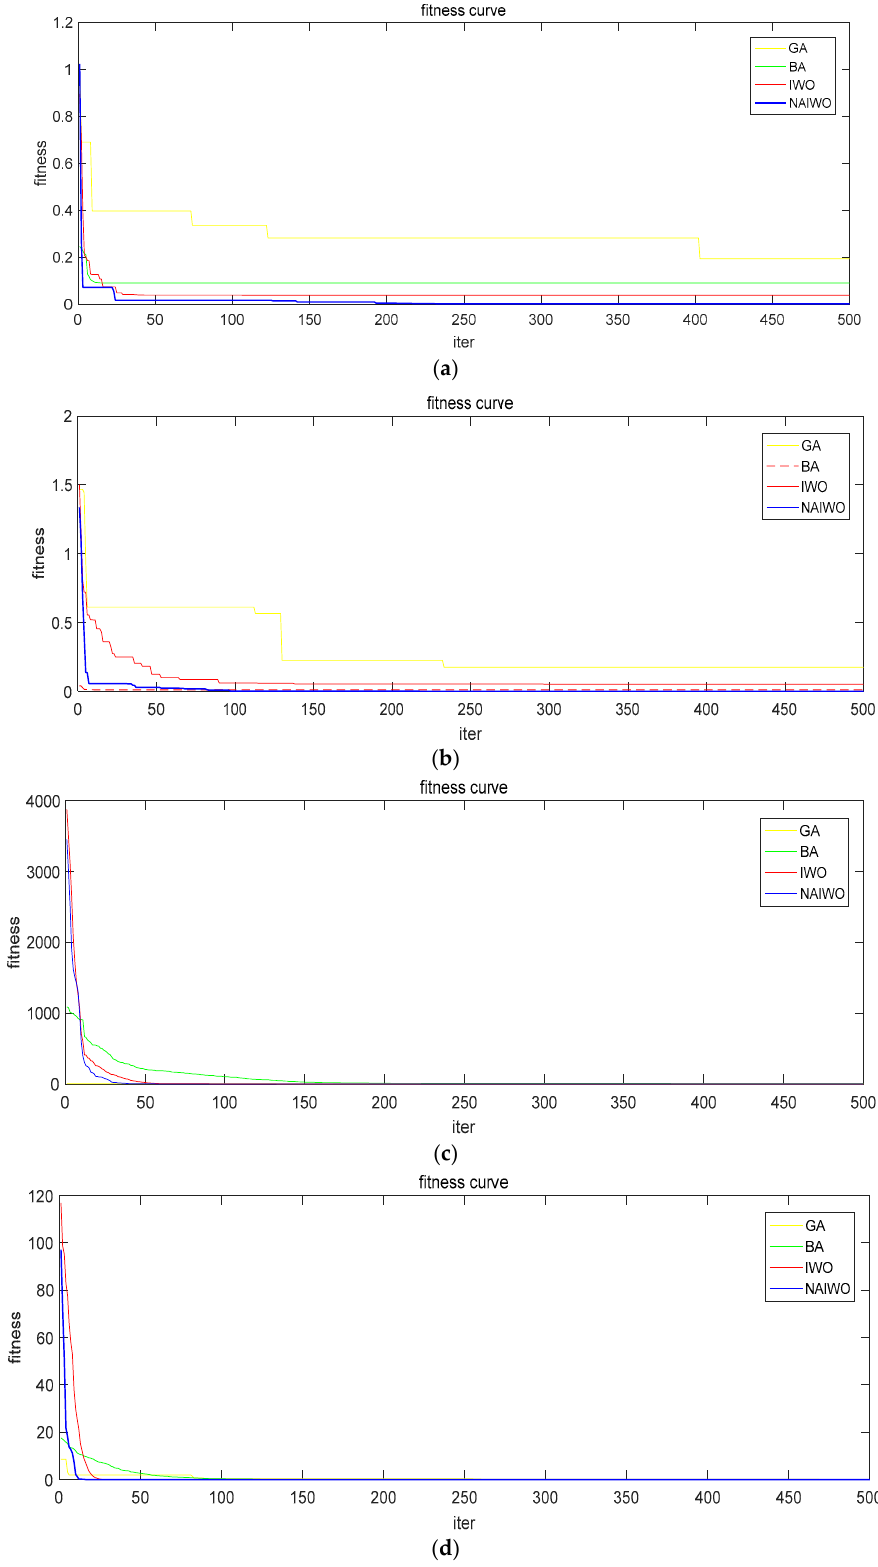
Figure A3. Comparison of the fitness curves between NAIWO, IWO, GA, and BA. The maximum number of iterations selected in the test is 500. ( a ) Griewank function (F10), ( b ) Rastirgin function (F11), ( c ) Colville function (F12), and ( d ) Powell function (F13).